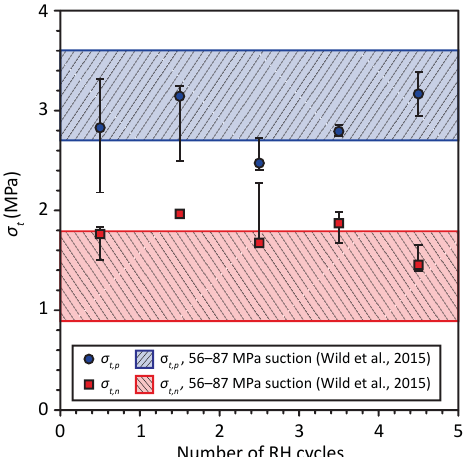
Figure 7. The median value and the associated ranges of the Brazil- ian tensile strength of specimens from the stepwise cyclic RH ex- periment with tension parallel ( σ t , p ) and normal ( σ t , n ) to bedding. Furthermore, the range of Brazilian tensile strength values reported by Wild et al. (2015) for specimens that were equilibrated to 56– 87MPa suction are indicated. Figure 8. Water retention curve for specimen N7 displaying suc-